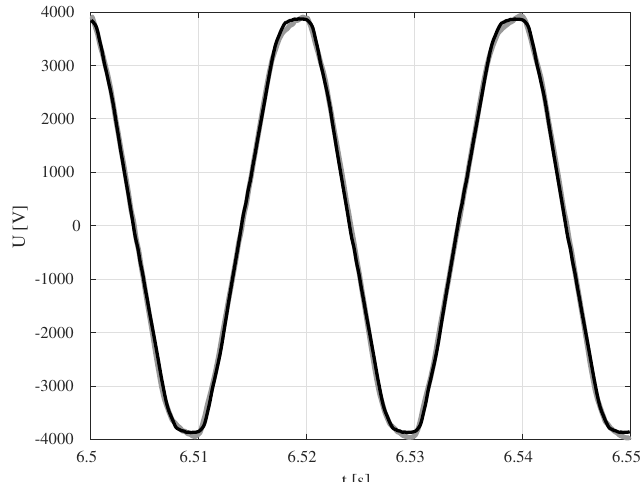
Figure 9. Momentary values of input (black) and output (gray) voltages.